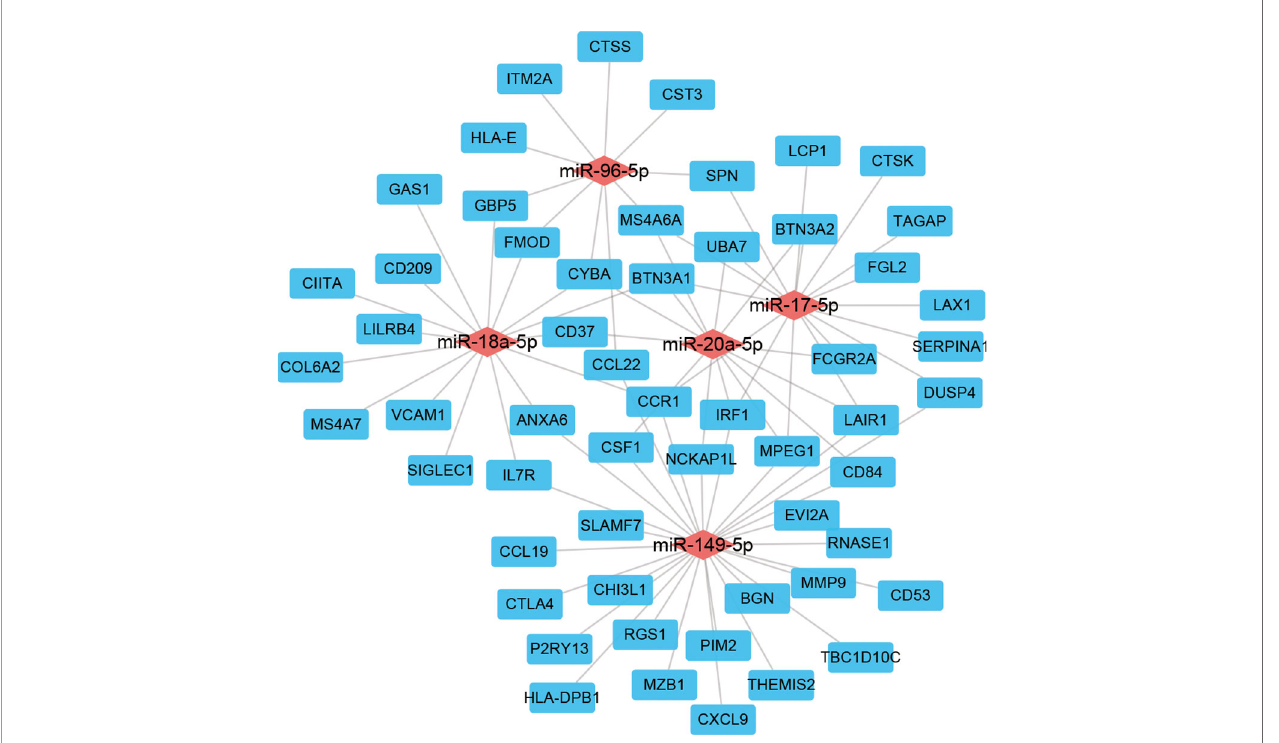
FIGURE 5 | ceRNA network of genes, miRNAs, and lncRNAs differentially expressed both in the TCGA and GEO